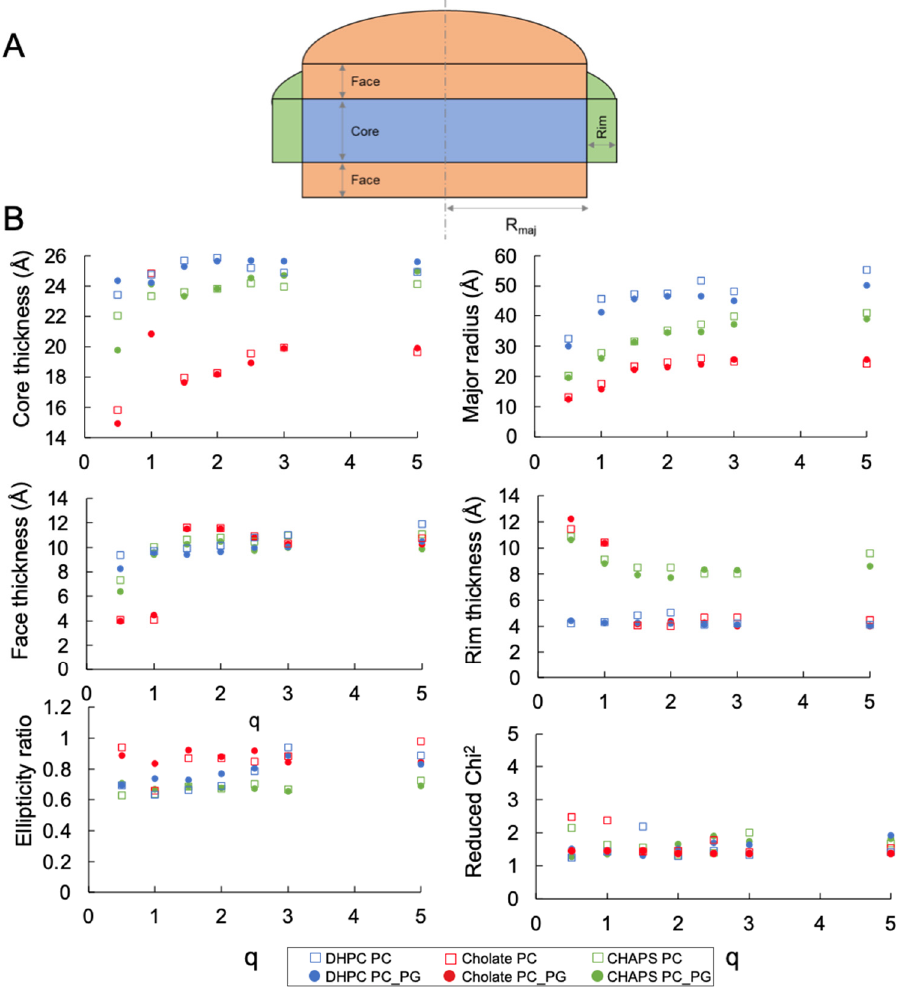
Figure 5. ( A ) Cartoon representing the bicelle model implemented in SASview used to fit the SAXS data. The ellipticity ratio defines the minor radius orthogonal to the major radius in the bilayer plane ( B ) Parameters of the best bicelle fits for the SAXS curves shown in Figure 3. Same colour scheme as in Figure 2. The full list of values is given in Table S2.